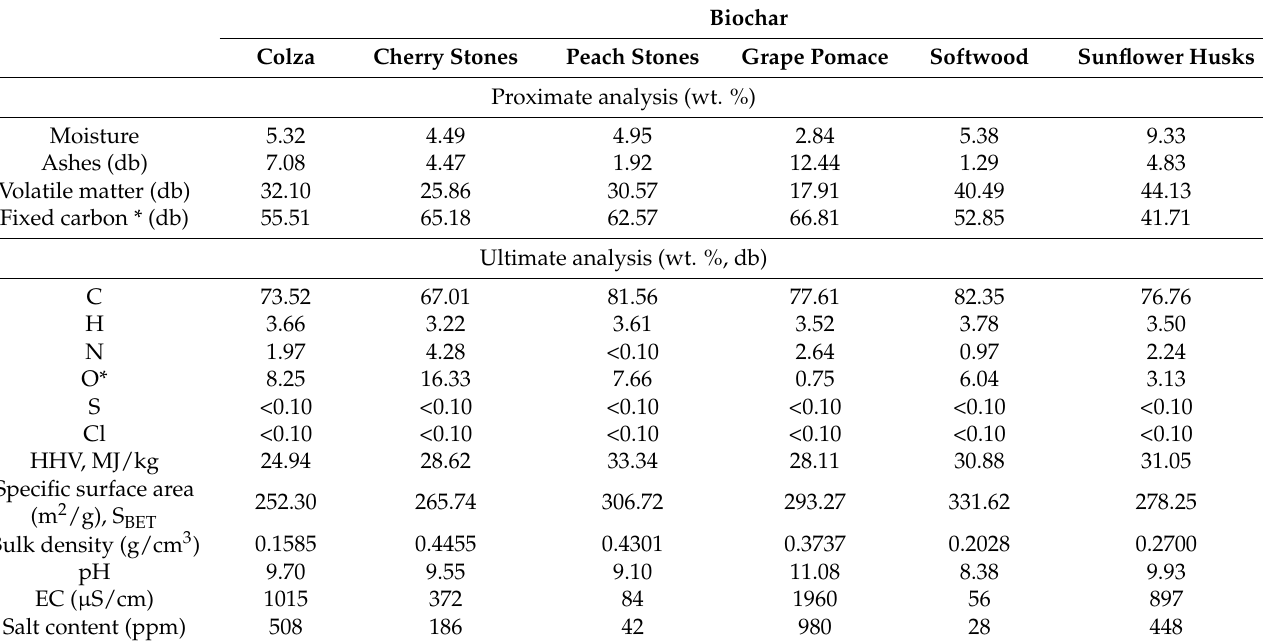
Table 4. Biochar characteristics.